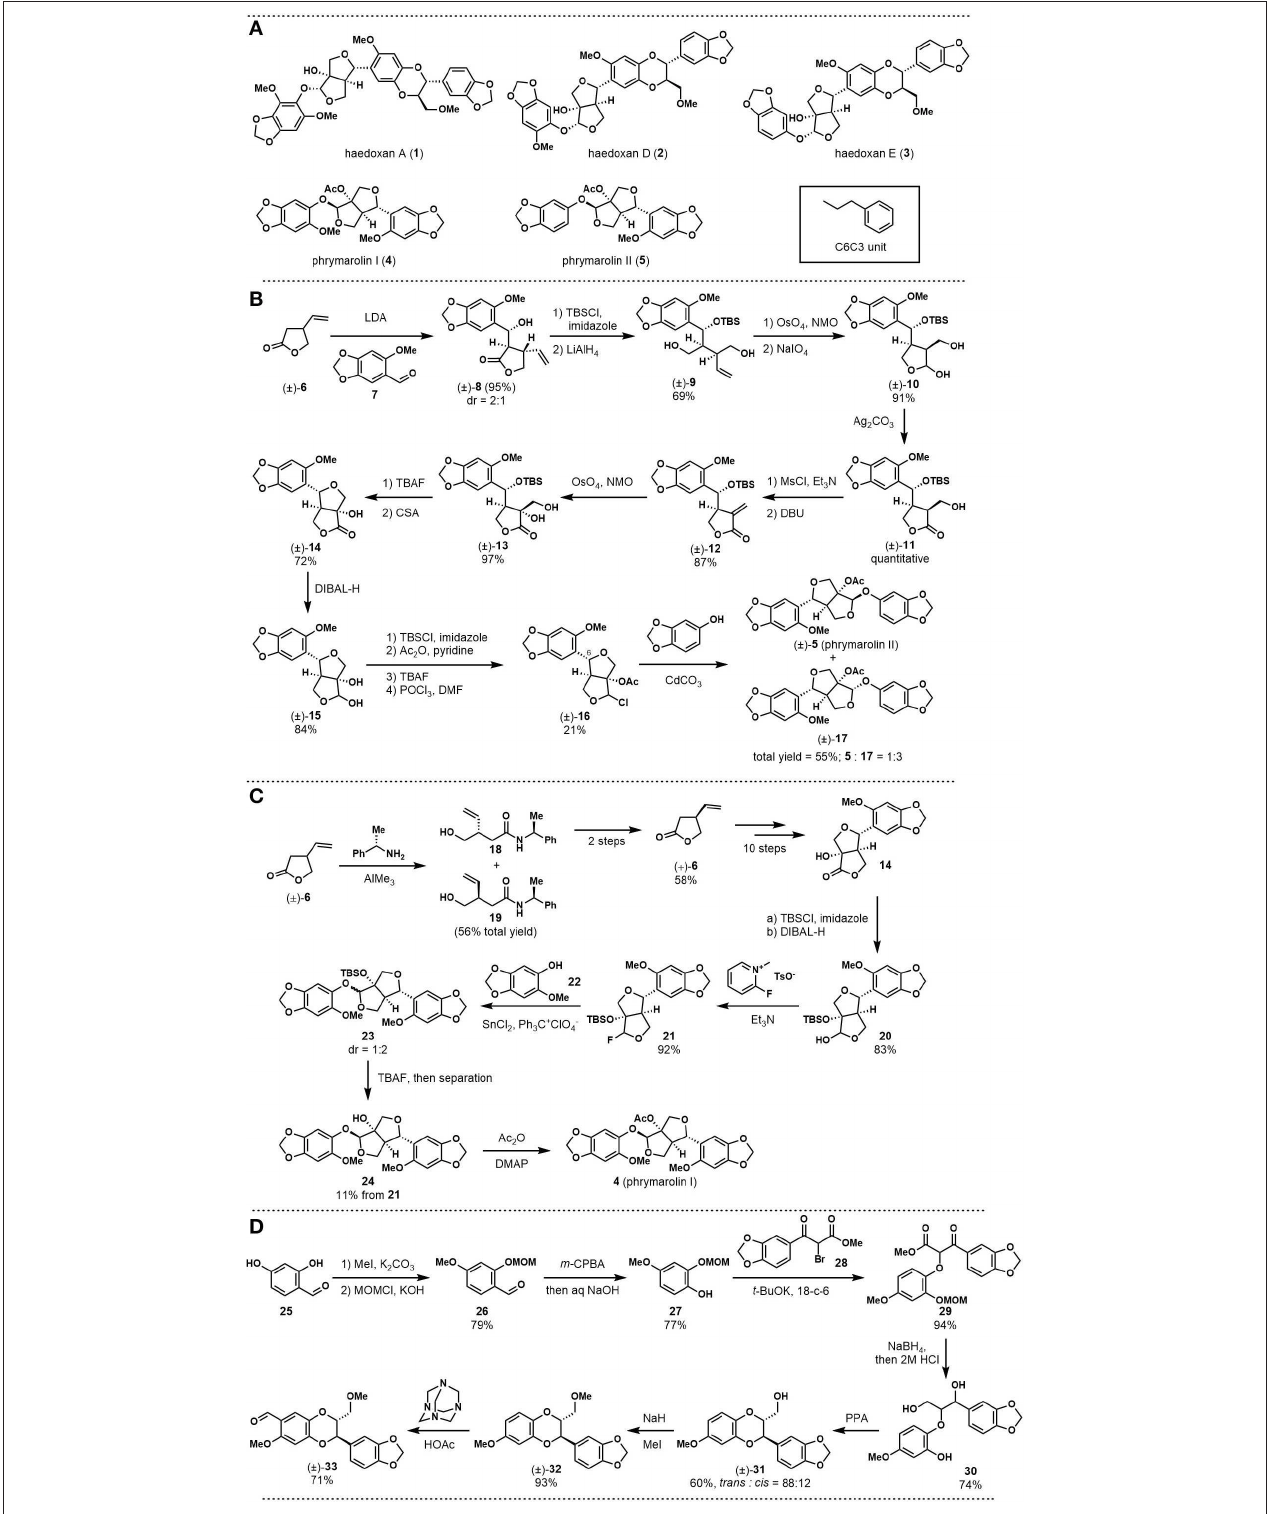
FIGURE 1 | (A) Structures of haedoxans and phrymarolins; (B) Taniguchi’s first total synthesis of ( ± )-phrymarolin II; (C) Taniguchi’s total synthesis of ( + )-phrymarolin I; (D) Taniguchi’s synthesis toward ( ± )-haedoxan A, D, and E: fragment preparation.